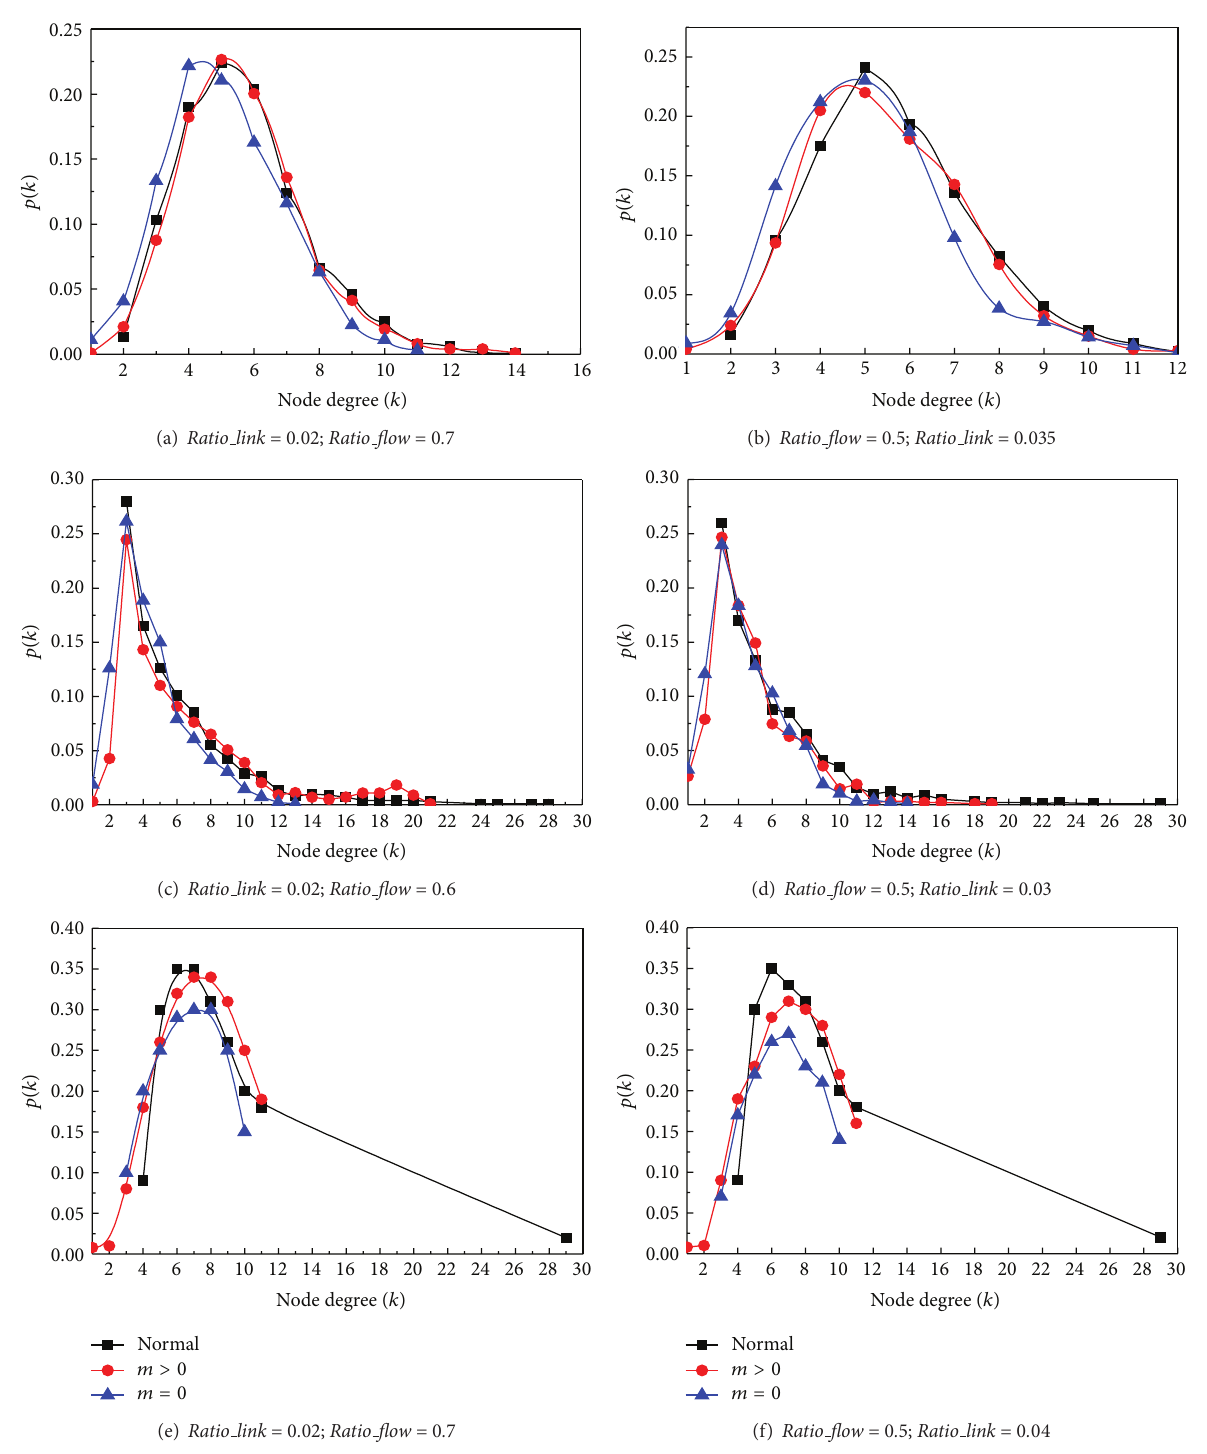
Figure 7: Network shifts from link failure recovery in different network